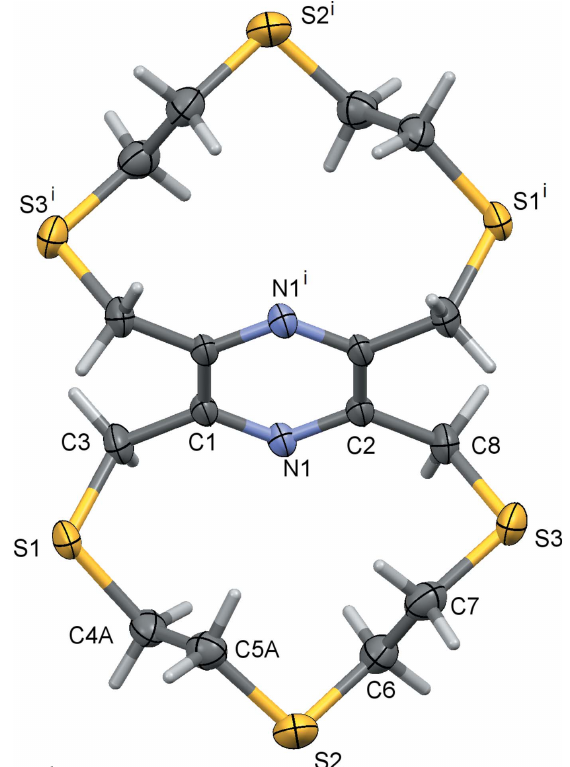
Figure 1 A view of the molecular structure of compound I , the regioisomer m -bis L1, with atom labelling for the asymmetric unit [symmetry code: (i) (cid:4) x , (cid:4) y , (cid:4) z + 1]. Displacement ellipsoids are drawn at the 50% probability level. For clarity, the minor components of the disordered atoms in the chains have been